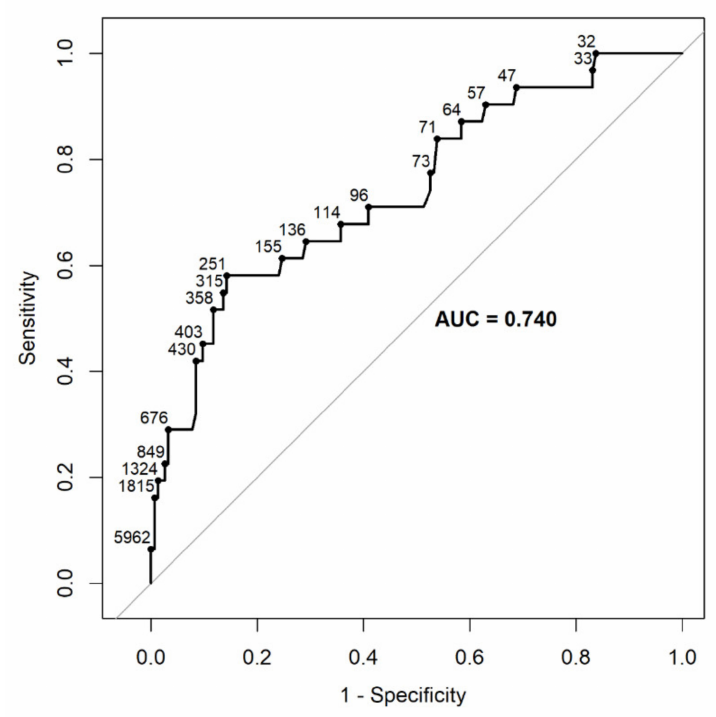
Figure 2. The relation of NT-proBNP levels and values of mean pulmonary artery pressure measured on right heart catheterization The receiver operator characteristic plot demonstrates sensitivity, specificity, and the area under the curve for the relation of NT-proBNP levels with values of mean pulmonary artery pressure measured on right heart catheterization ≤ 35 or >35 mm